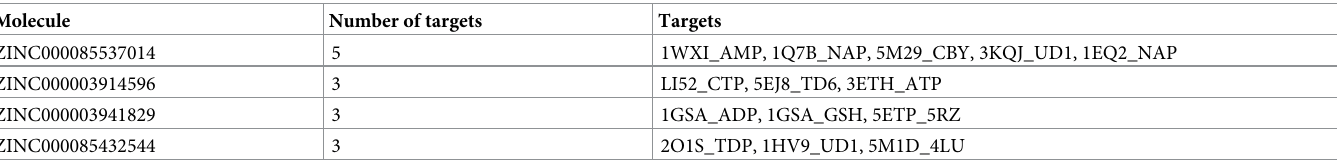
Table 3. Polypharmacology molecules selected based on the top rank of